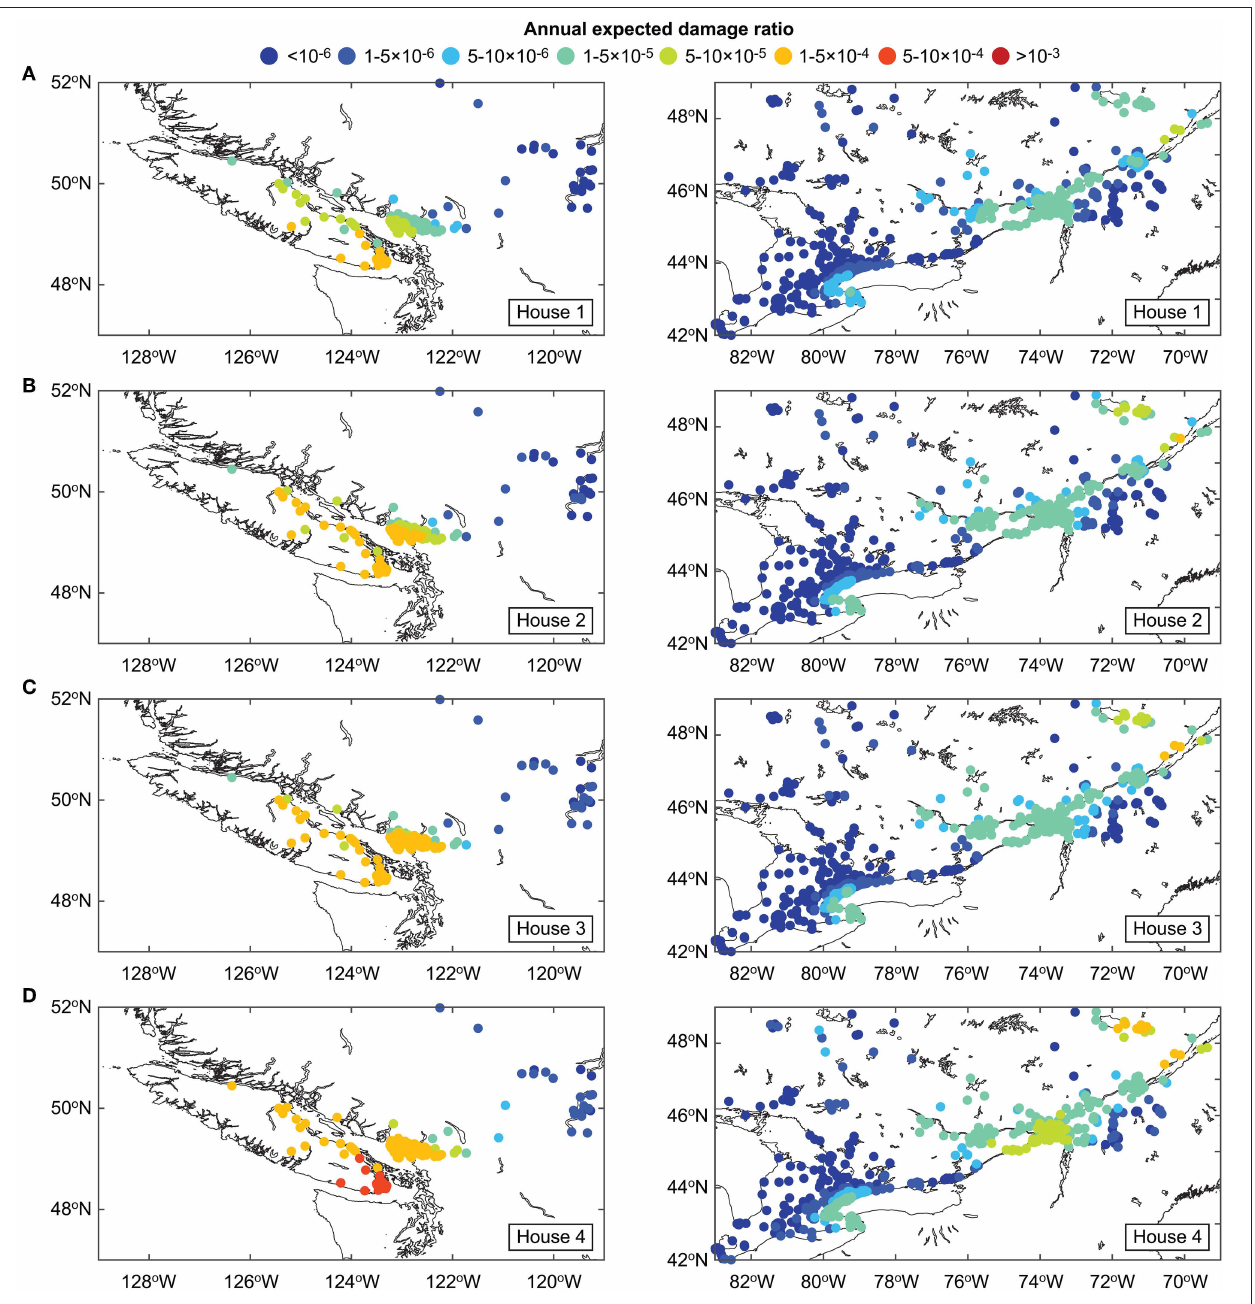
FIGURE 12 | Seismic risk maps in terms of annual expected damage ratio for western and eastern Canada: (A) House 1, (B) House 2, (C) House 3, and (D) House 4.